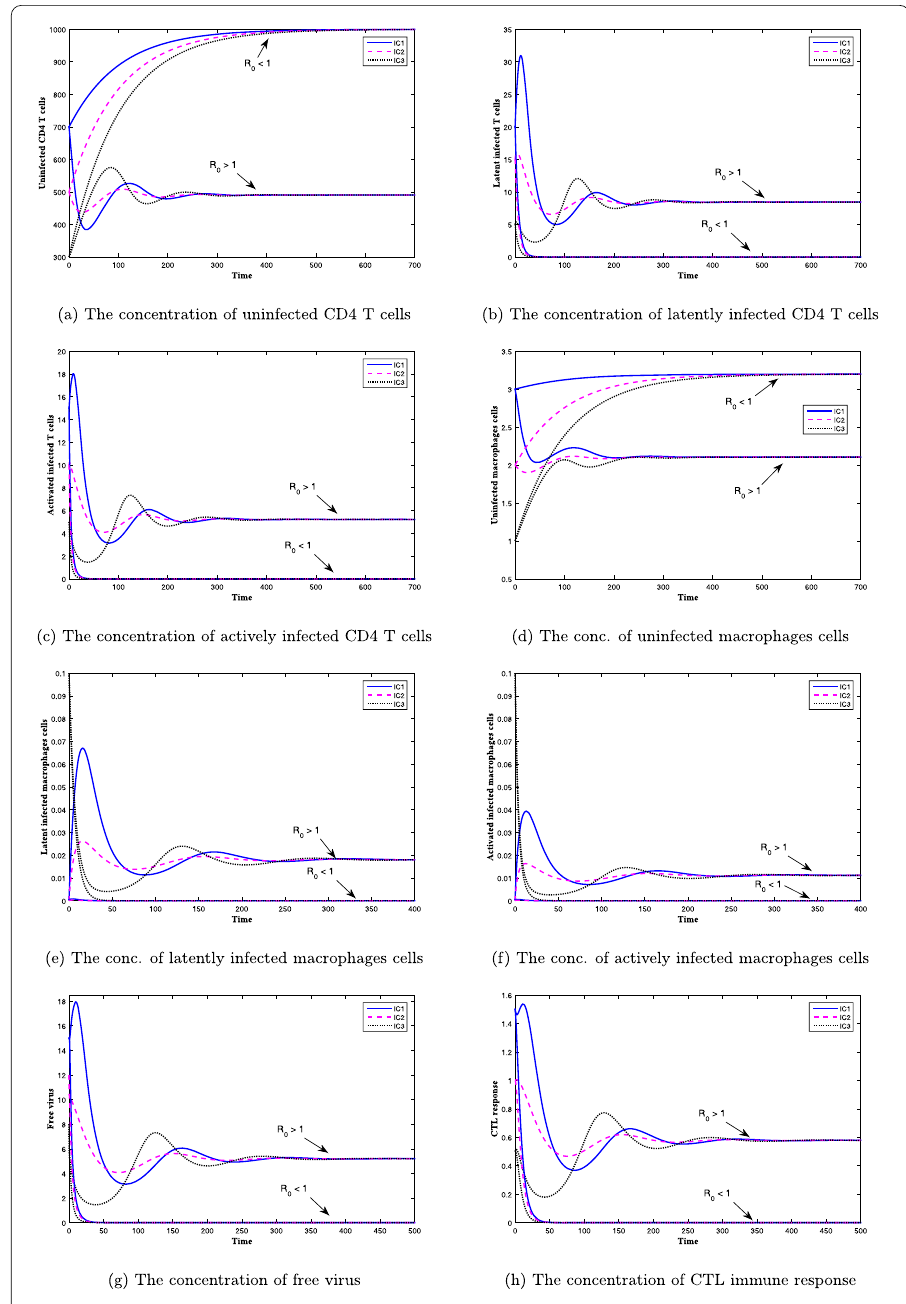
Figure 1 The evolution of model (6)–(13) with varied infection rates